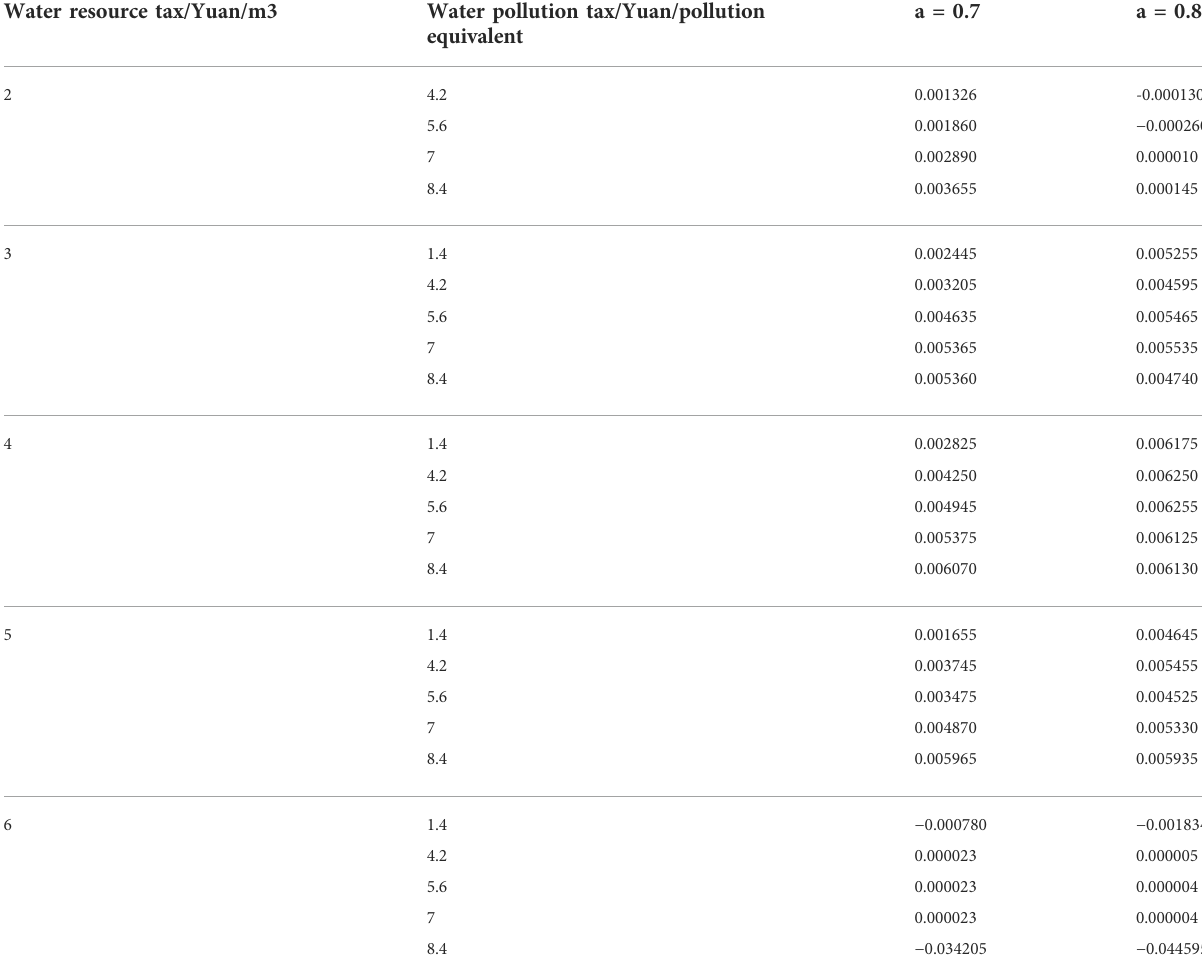
TABLE 6 Optimization of tax